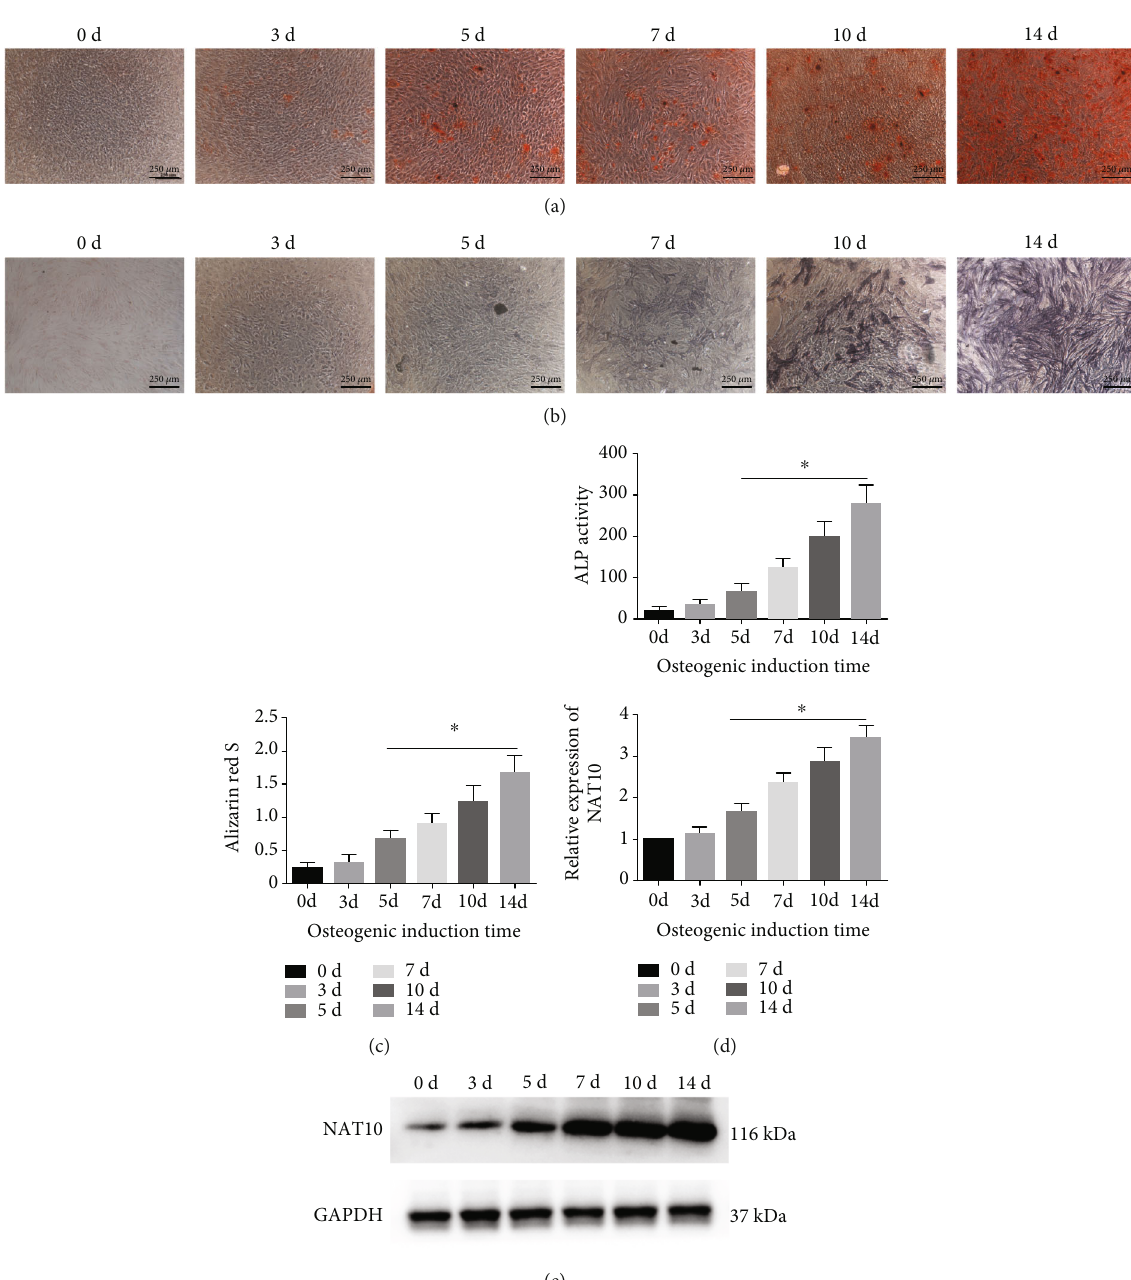
Figure 1: NAT10 was upregulated during osteogenic di ff erentiation of MSCs. (a) Staining of ARS showed increased calcium nodule formation from day 0 to day 14 of induction. Scale bar = 250 μ m . (b) The ALP staining intensity increased from day 0 to day 14 of induction. Scale bar = 250 μ m . (c) The quanti fi cation of ARS staining increased from day 0 to day 14 of induction. (d) The ALP activity increased from day 0 to day 14 of induction. (e) The protein expression of NAT10 increased gradually from day 0 to day 14 of induction. ∗ indicates P < 0 : 05 . All experiments were repeated three